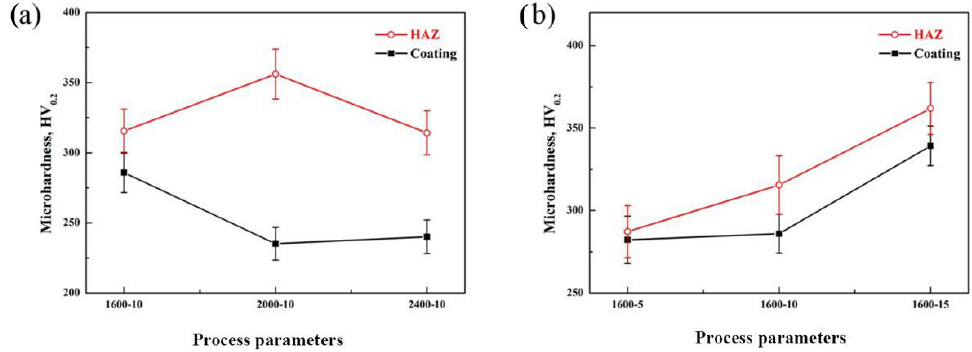
Figure 7. Factors affecting the microhardness of coating-substrate: ( a ) effects of laser power and ( b ) effects of scanning speed.